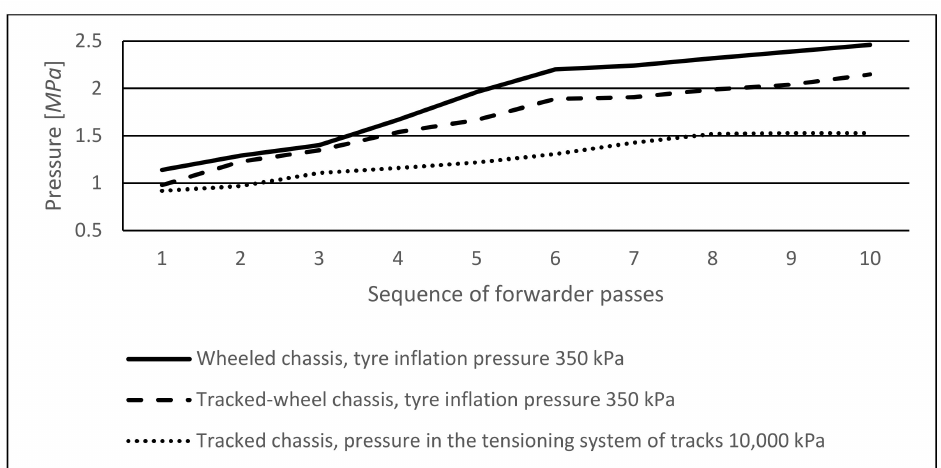
Figure 9. Soil profile compaction at a depth of 15 cm during ten passes of three chassis variants of the loaded forwarder.